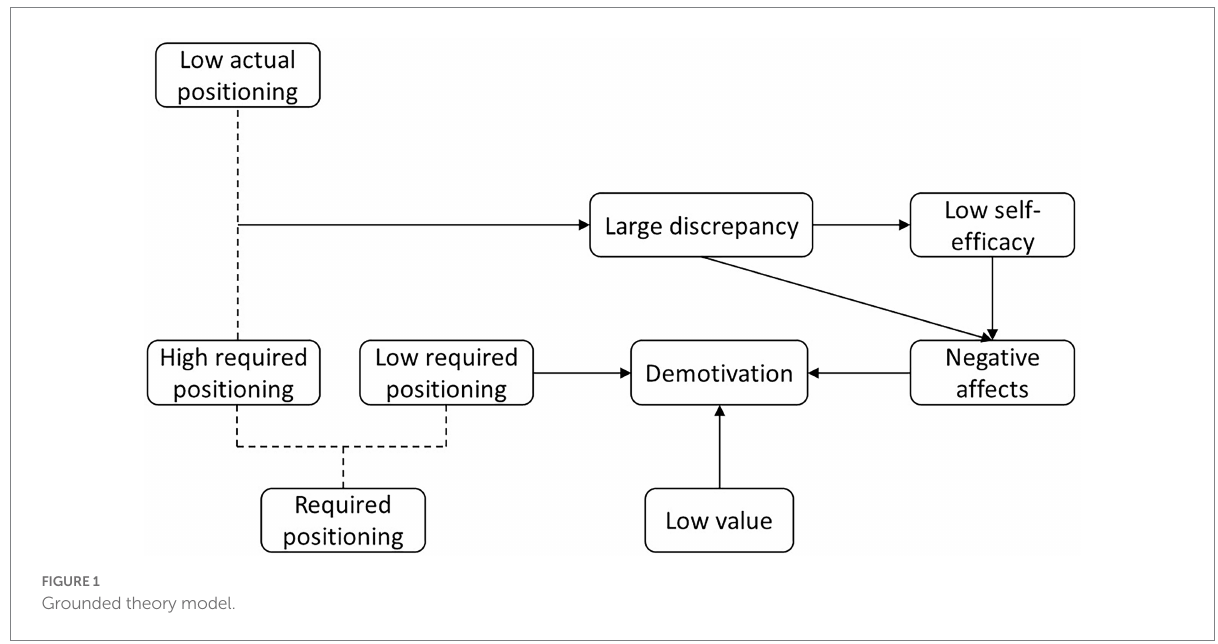
FIGURE 1 Grounded theory model.